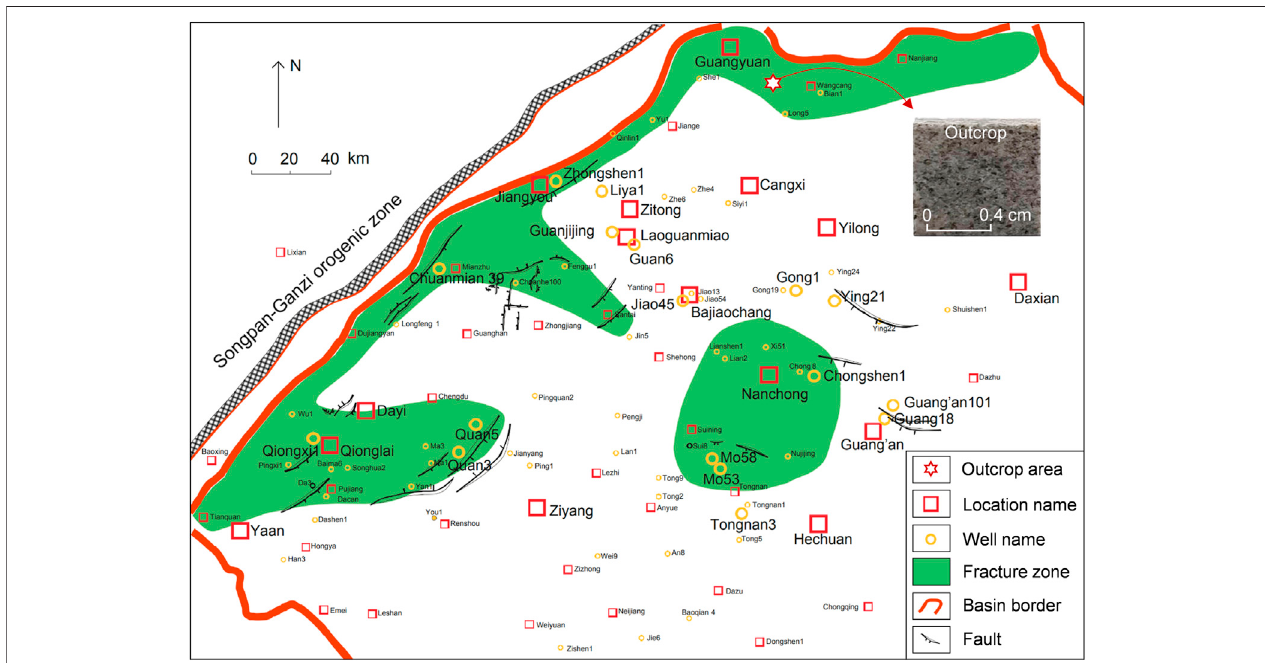
FIGURE 1 | Outcrop area and the sandstone studied in this paper (after (Jiang et al., 2009))